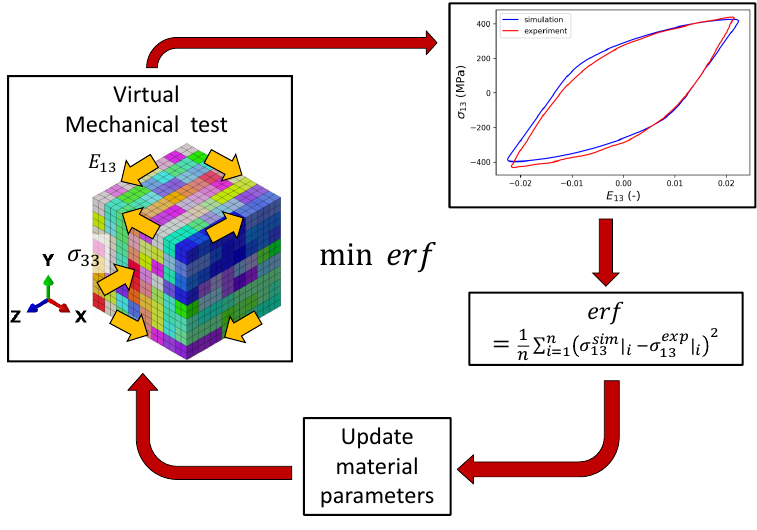
Figure A3. Flow diagram of the optimization algorithm used for optimizing the material